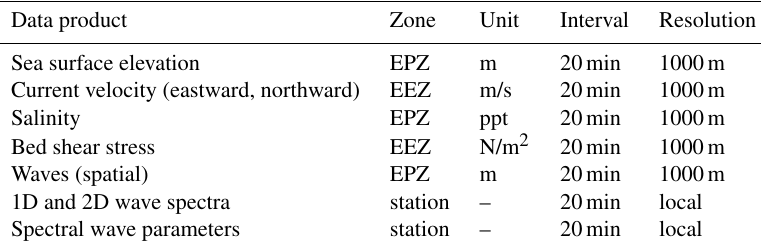
Table A1. Model simulation